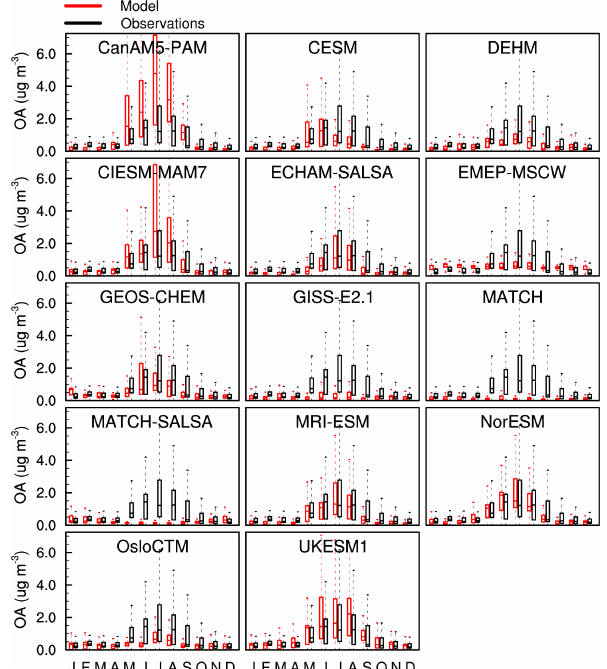
Figure 22. Monthly Arctic OA from models (red) and measure- ments (black) for 2014–2015.